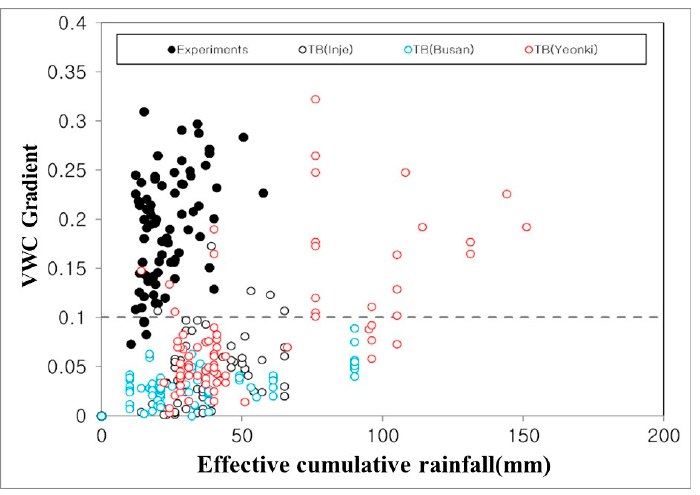
Figure 8. Relationship between volumetric water content gradient (VWC) and effective cumulative